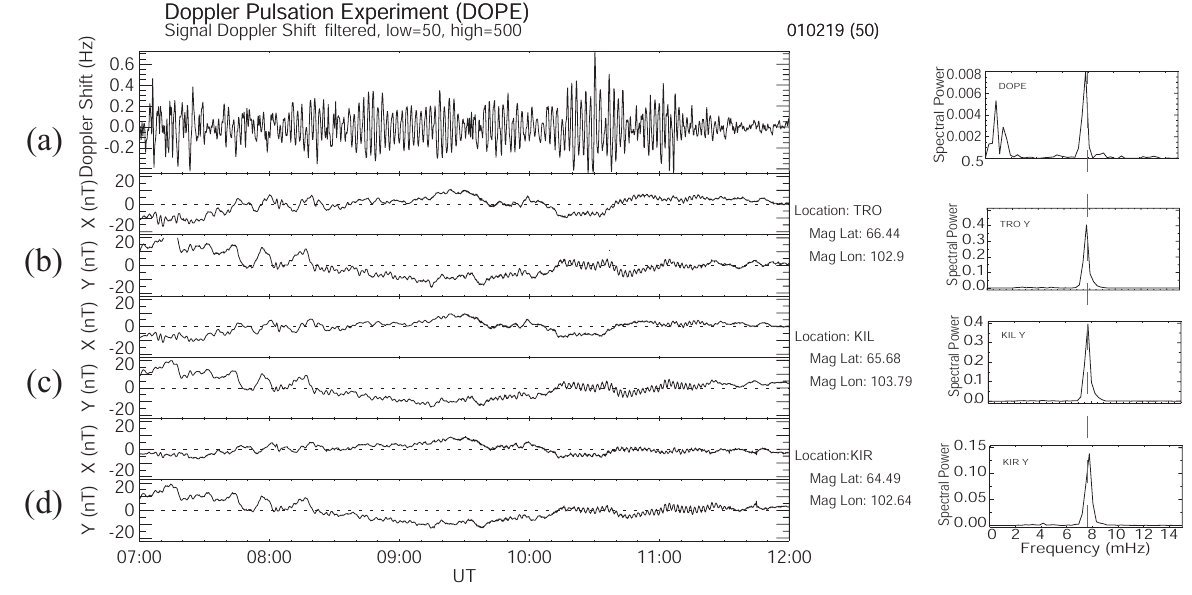
Figure 8. Fig. 8. ( a ) indicates a Doppler trace from the DOPE HF sounder for the event on the 19th February 2001. ( b ) , ( c ) and ( d ) indicate magnetometer data from the TRO, KIL and KIR stations respectively. Panel (a) indicates that the wave was observed by DOPE between 08:00 and 11:40 UT (10:00–13:40 MLT) and panels (b)–(d) indicate the wave observed by the magnetometers between 10:20 and 11:40 UT (12:20 to 13:40 MLT). The panels to the right of the magnetometer and DOPE traces show the result of a FFT analysis undertaken of the DOPE data from 08:00–11:40 UT and the Y component of the magnetometer data from 10:20–11:40 UT. The dominant frequency component is at ∼ 8mHz for all the traces.